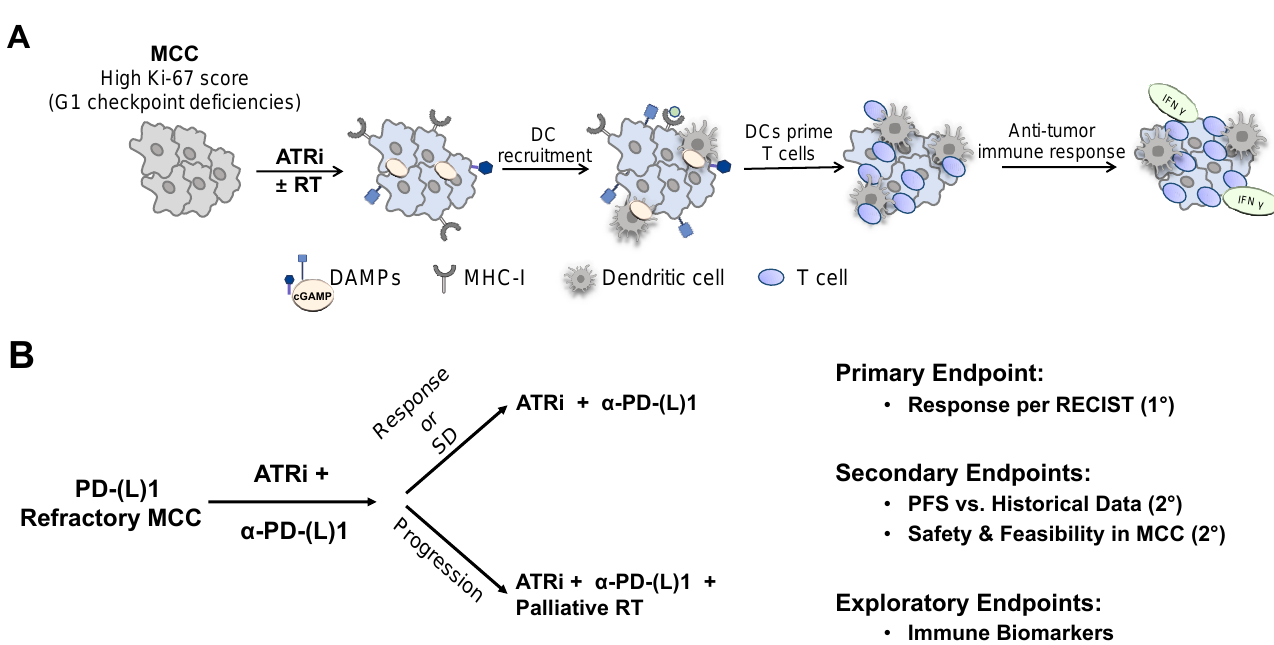
Figure 3. Potential role for an ATR inhibitor (ATRi) to overcome immune checkpoint inhibitor (ICI)-refractory Merkel cell carcinoma (MCC) and a clinical trial concept. ( A ) Prospective mechanism of action for an enhanced immune response in MCC treated with an ATRi ± radiotherapy (RT). ( B ) Schematic for a potential clinical trial of an ATRi for patients with MCC refractory to ICIs wherein an ATRi would be added to a patient’s ongoing PD-1 pathway blockade. Palliative RT may be utilized to control progressive lesions and potentially synergize with the ATRi. Abbreviations: cGAMP: cyclic guanosine monophosphate–adenosine monophosphate, α-PD-(L)1: anti-PD-(L)1, PFS: progression-free survival, RECIST: response evaluation criteria in solid tumors, SD: stable disease.